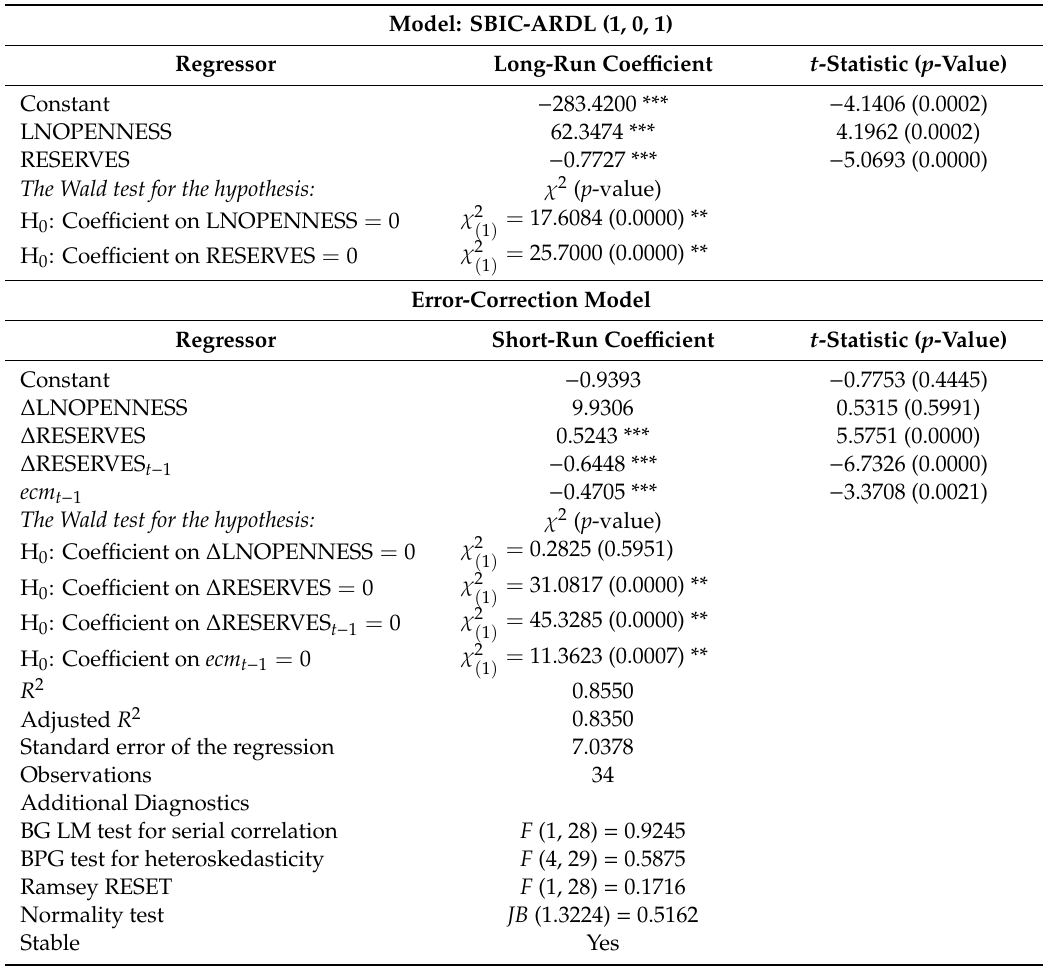
Table 5. Coe ffi cients of the determinants of capital flight